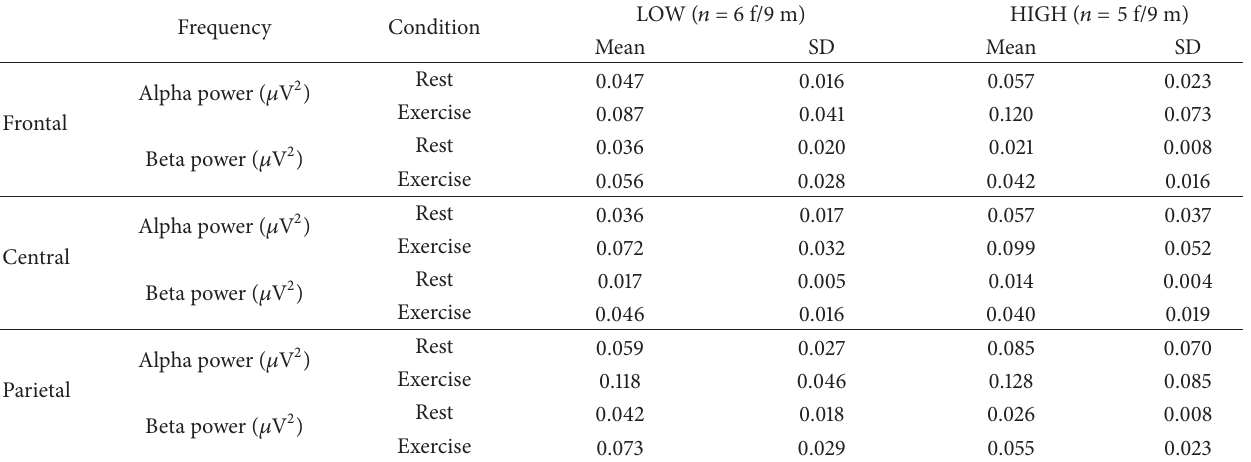
Table 2: Alpha and beta power at rest and during cycling in LOW and HIGH.